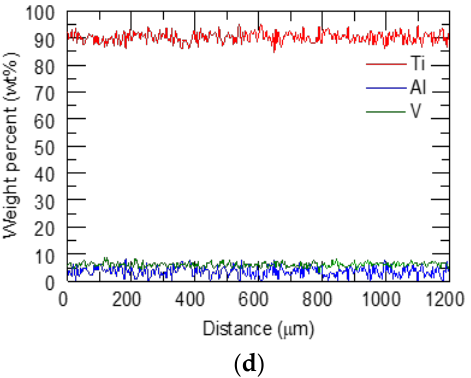
Figure 4. ( a ) Overview of the microstructure of the repaired region; ( b ) magnified view of the interface between deposits and substrate; ( c ) microstructure of deposits; ( d ) elemental distribution over the interface.